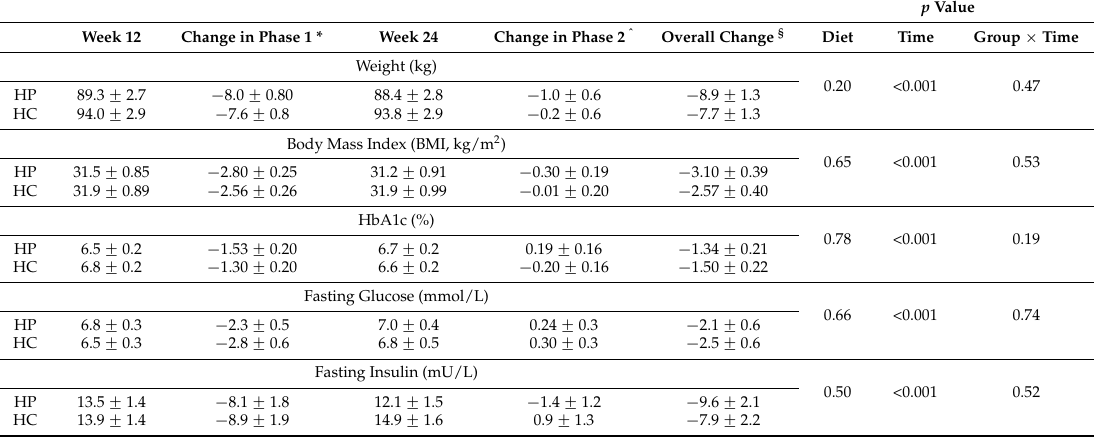
Table 3. Changes in outcomes for weight, glycaemic control, body composition, blood pressure, HOMA2-IR, and CRP following 12 weeks weight loss (Week 12) and 12 weeks weight maintenance (Week